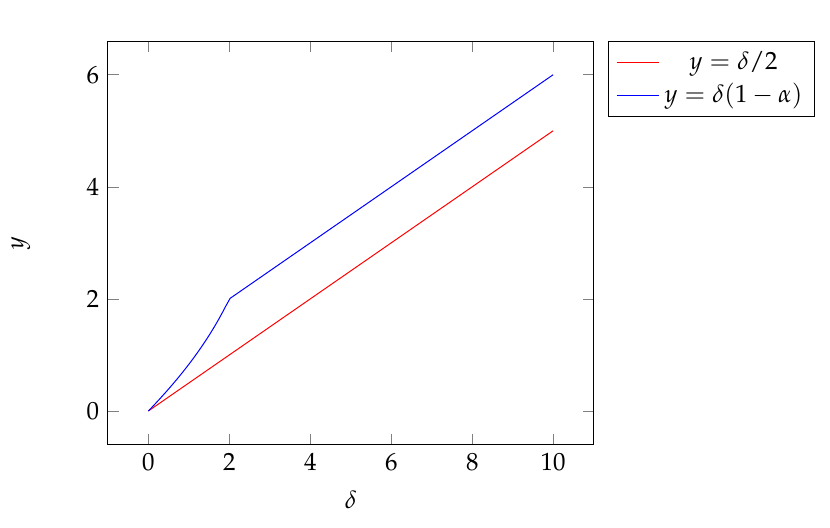
Figure 1. Comparison of the